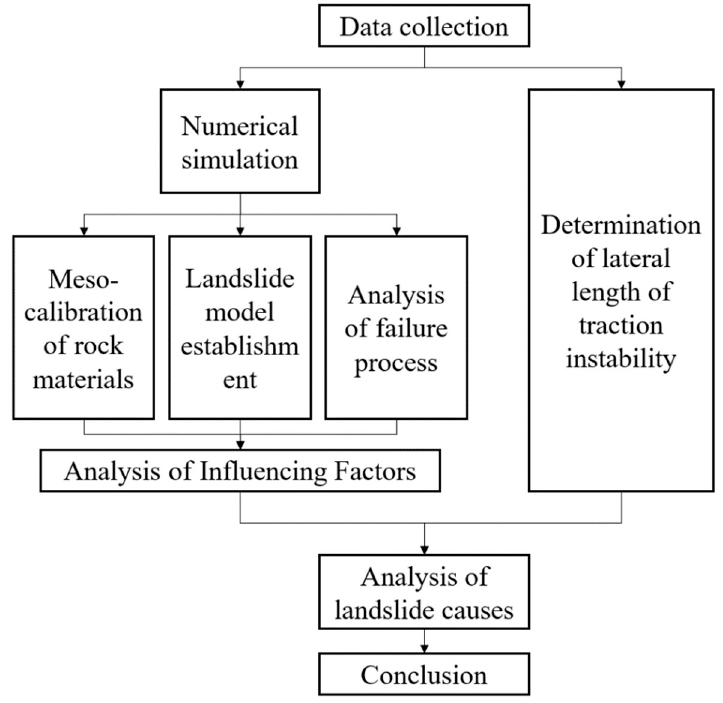
Figure 1. Technical flow